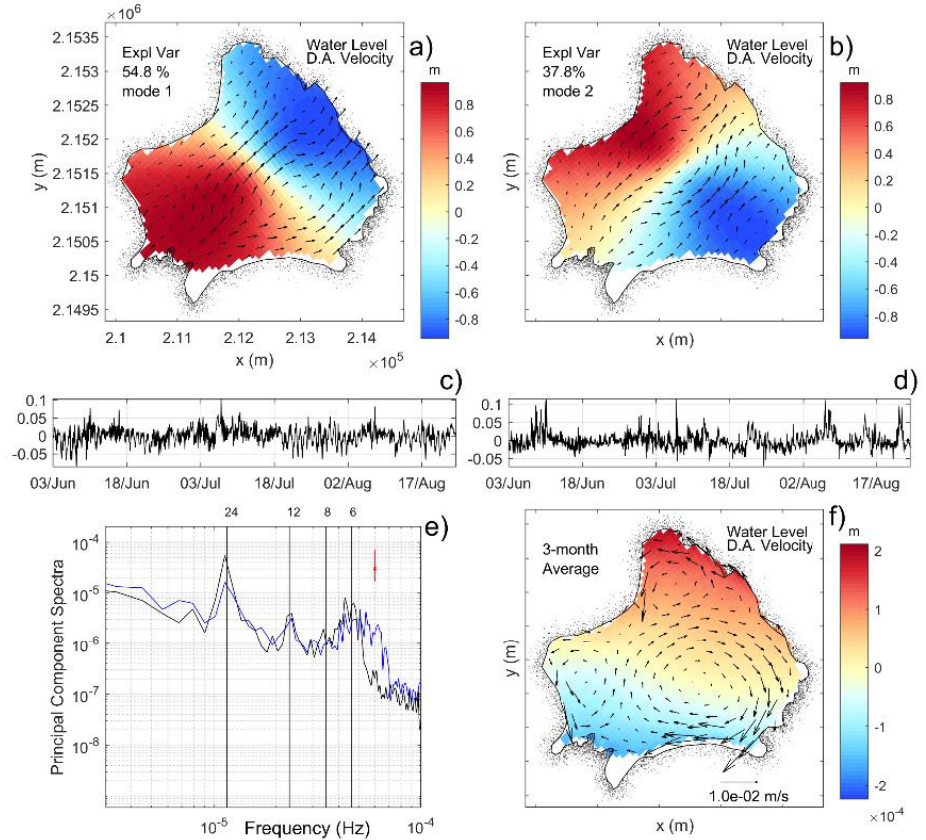
Figure 19. Empirical orthogonal functions of water level and depth average velocity. In ( a ) and ( b ), the spatial variabilities, with their corresponding principal components at ( c ) and ( d ), are shown. Note that the actual water level is obtained from the product of the value of the spatial variability and temporal variability. The power spectral density of the principal components (mode-1 black, mode-2 blue) of water level in ( e ). Oscillation periods at the surface show perturbations that span for 24, 12, and 8 h and from 3 to 5 h. ( f ) shows the three-month average of the depth-averaged currents and water level.